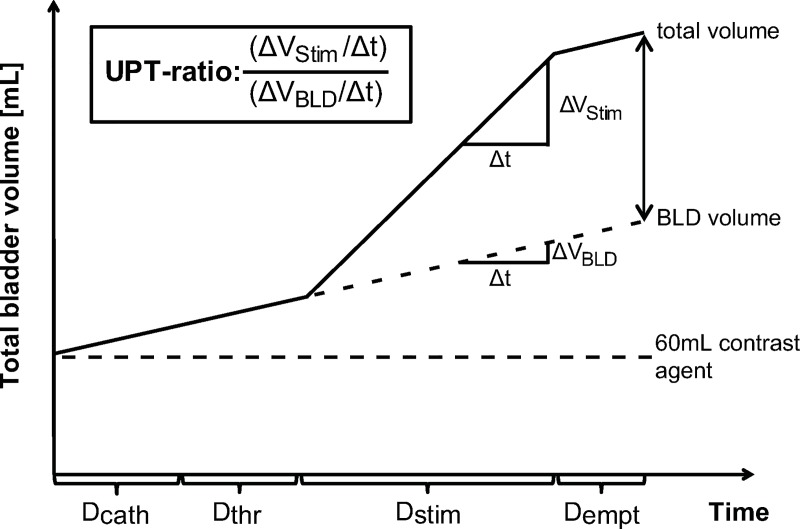
Calculation of outcome measure “Urine production per time (UPT)-ratio”.During each section (Dcath, Dthr, Dstim, Dempt) of the stimulation cycle we assumed baseline UPT based on the bladder diary (BLD) measurements (UPTBLD). In our model we further assumed increased UPT during electrical stimulation (UPTStim). The outcome measure “UPT-ratio” was calculated by dividing UPTStim
(ΔVStim/Δt) by UPTBLD
(ΔVBLD/Δt). In summary, the outcome measure describes to which factor the UPT was higher during Dstim compared to the baseline value from the BLD. Dcath = time [s] used for catheter positioning at specific stimulation location; Dthr = time [s] used for current perception threshold (CPT) / pain threshold assessment and definition of absolute stimulation intensity (STIMINT); Dstim = time [s] used for electrical stimulation (500 stimuli); Dempt = time [s] used for bladder emptying. ΔV = volumetric changes, Δt = time difference.